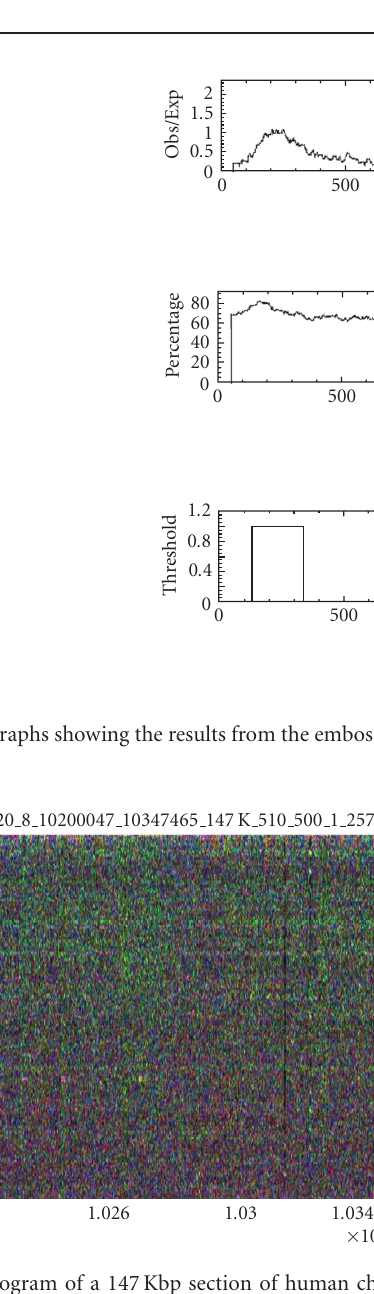
Figure 15: Spectrogram of a 147 Kbp section of human chromo- some 22. Periodicity is shown on vertical scale. Contrasted with Figure 9, this spectrogram shows that the chromosome-wide peri- odicities found in human chromosome 22 are qualitatively di ff er- ent from those found in the right arm of C. elegans chromosome III. The periodicities here are much more finely embedded in the DNA and do not represent any obvious family of strings discretely interspersed throughout the region. Arrows point out some of the chromosome-wide periodicities found in Figure